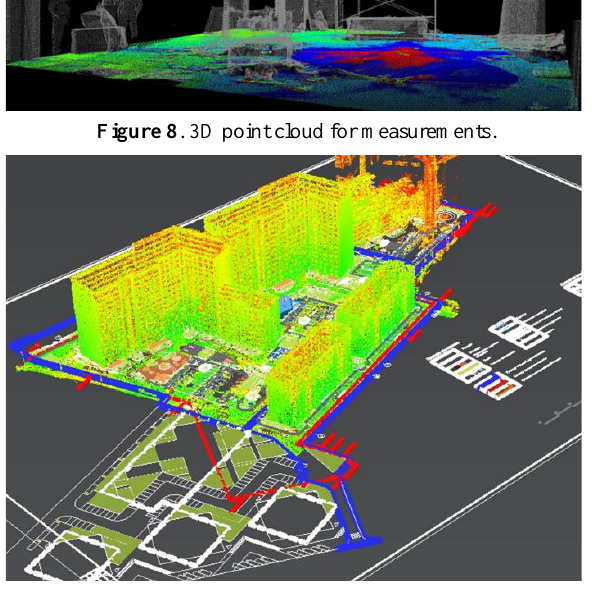
Figure 9 . Fusion of 3D point cloud with BIM.